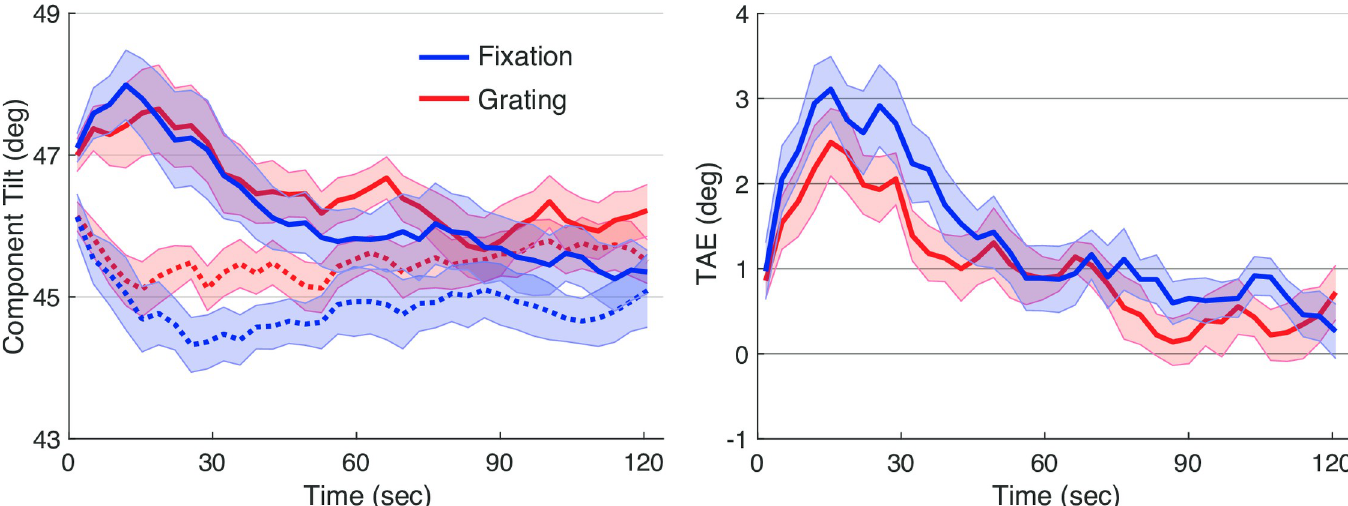
Fig 4. Results of experiment 1. The left panel shows results of the TAE Task, when interleaved with the Grating Task (red) and with the Fixation Task (blue), during baseline (before adaptation., dotted) and following adaptation (solid). The right panel shows effects of adaptation computed by subtracting the baseline TAE from TAE after adaptation, for each secondary task, separately. Lines plot means across participants and error ribbons indicate +/- one standard error of the mean.